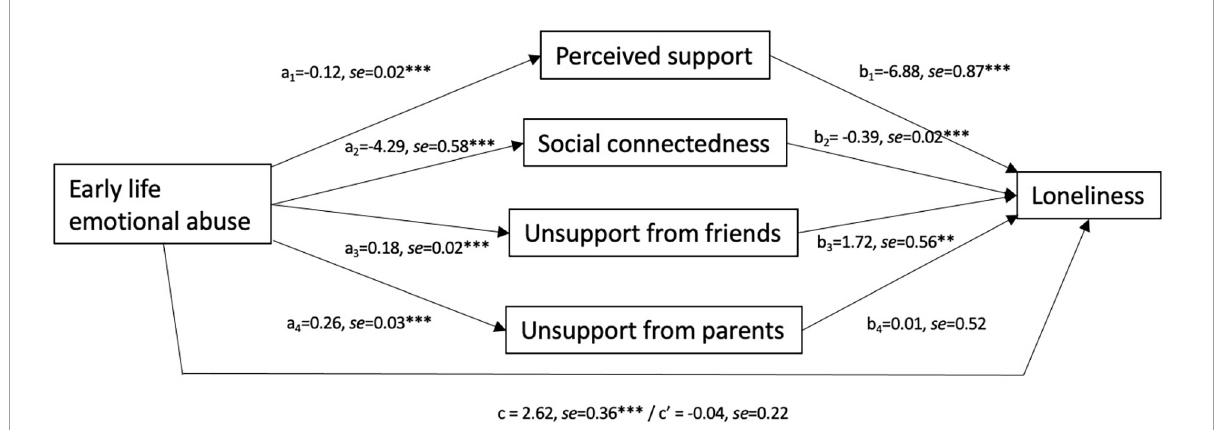
FIGURE2 Mediated relationship between experiences of early life emotional abuse and loneliness through social support characteristics in Study 2. Path coefficients indicate that emotional abuse was associated with perceptions of support, social connectedness and unsupport from both friends and parents, and all but unsupportive interactions with parents predicted, in turn, feelings of loneliness. Although emotional abuse was related to loneliness, the diminished social processes fully mediated this relationship. c represents the total effect, whereas c’ represents the direct effect. ∗∗ p < 0.01; ∗∗∗ p < 0.001. N =